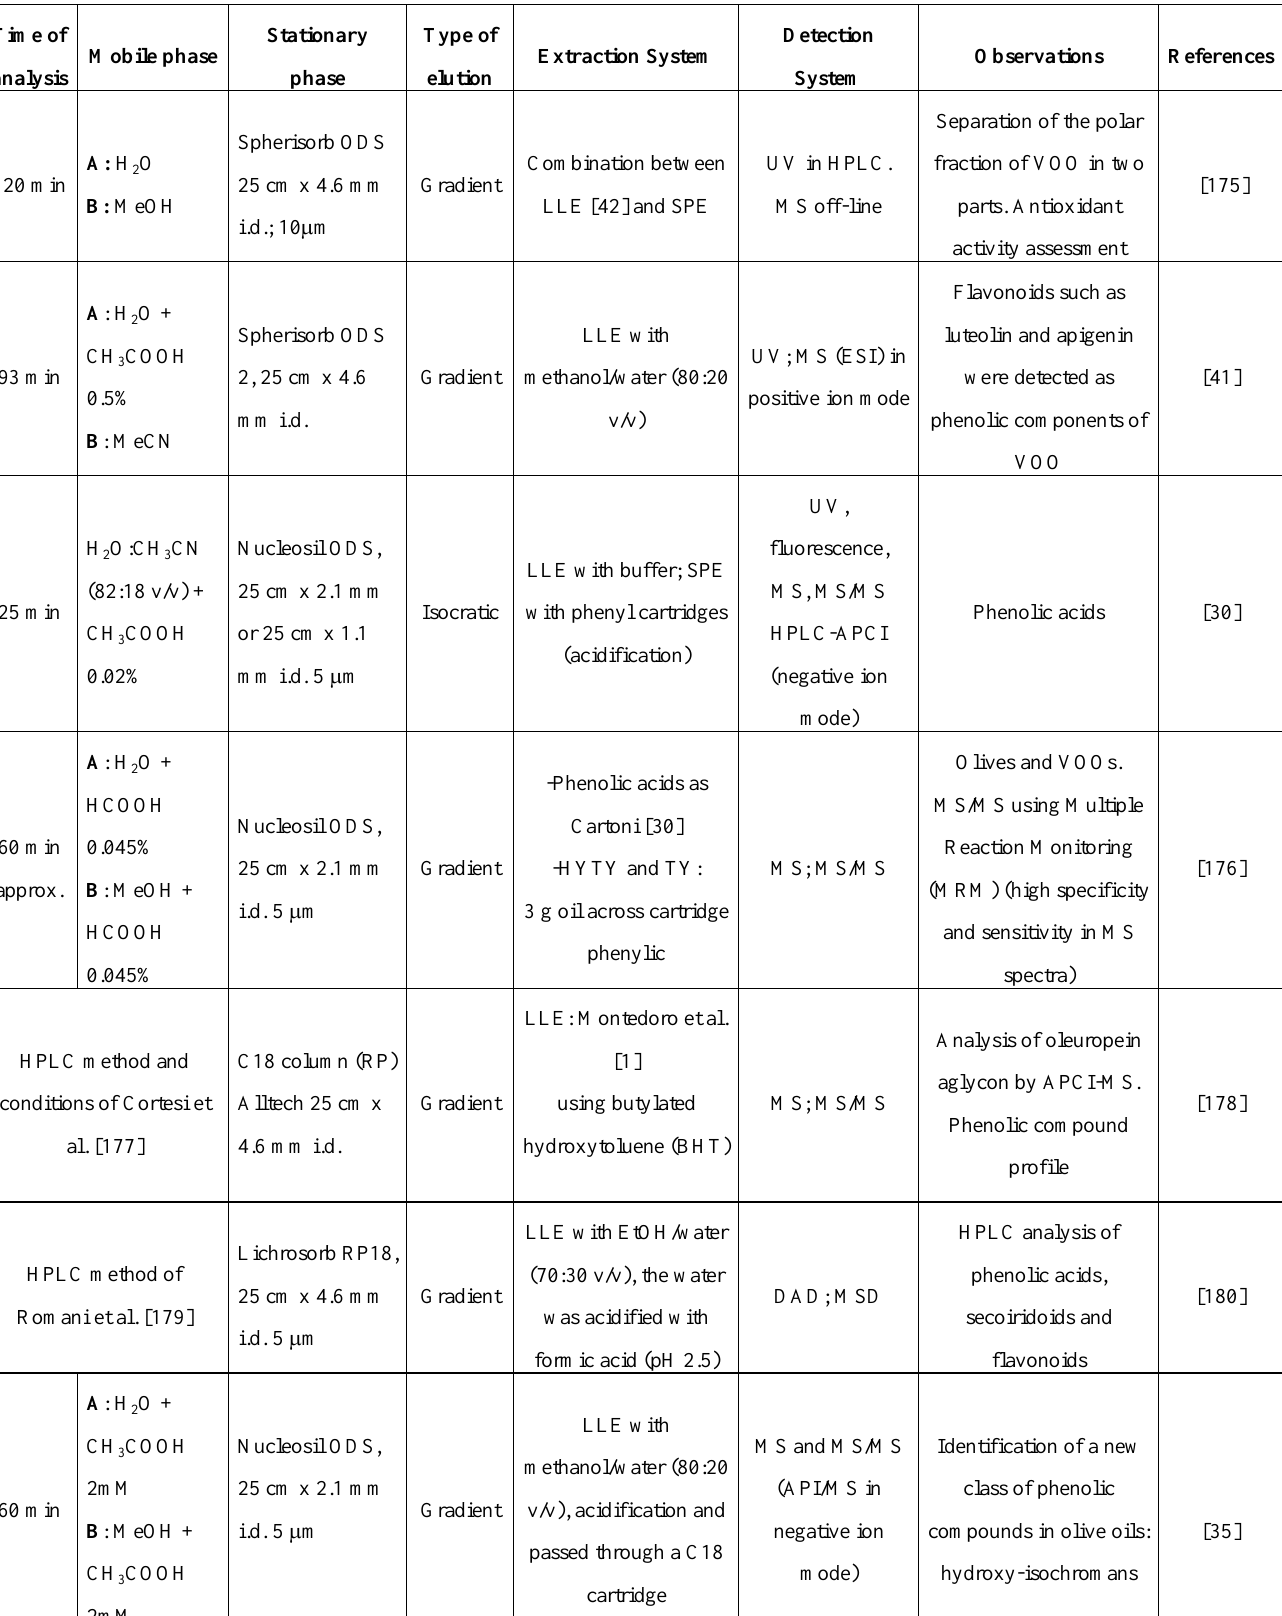
Table 2 . Summary of separation of phenolic compounds in the polar fraction of VOO using HPLC-MS